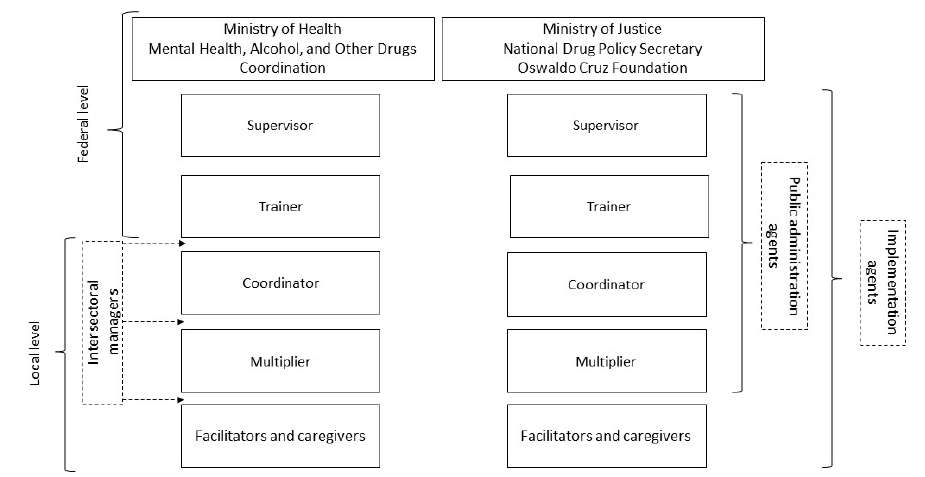
Figure 1. The organizational flow of the implementation of the Strengthening Families Program (SFP) 10–14 in Brazil.